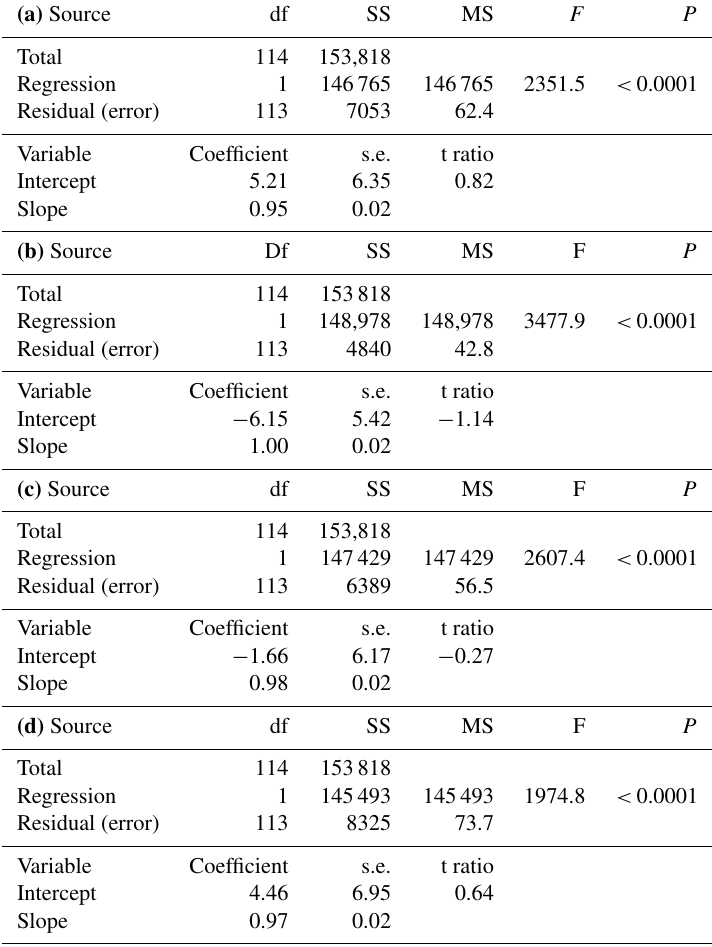
Table 3. ANOVA table for simple linear regression between the PAN and (a) DBS, (b) BRE, (c) OMT, and (d) OMD data. The column headings df, SS, MS, F , and P stand for degrees of freedom, sum of squares, mean square, F ratio, and P value,